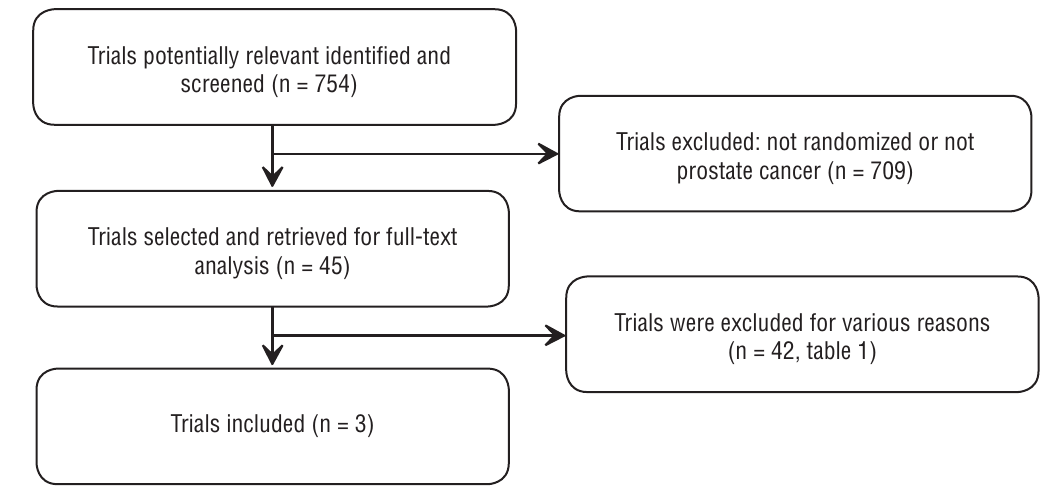
Figure 1 - Trial selection fl